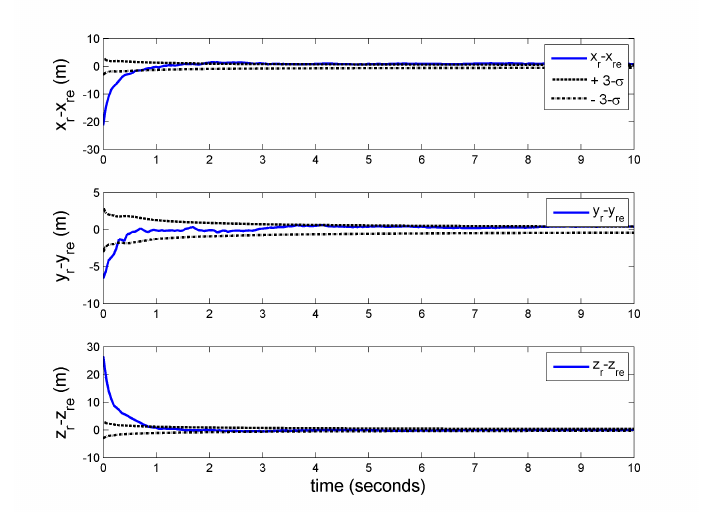
Figure 7. Position tracking errors (true-estimated) with 3 − σ bounds for target UAV (Case 1B).